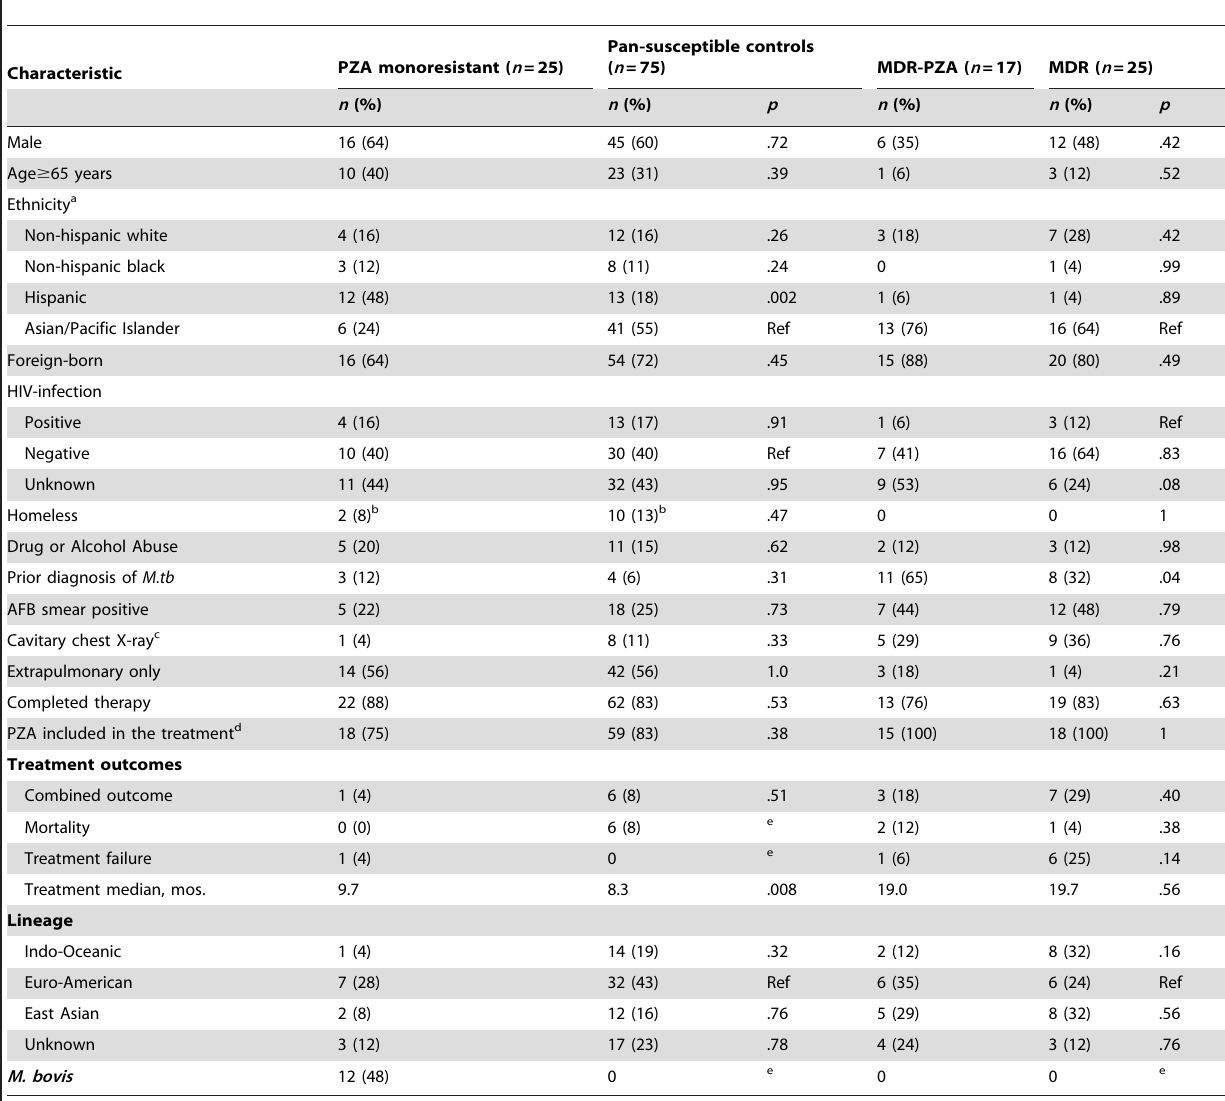
Table 2. Characteristics of patients with drug susceptible, PZA resistant, and MDR mycobacterial infection in San Francisco between 1991 and